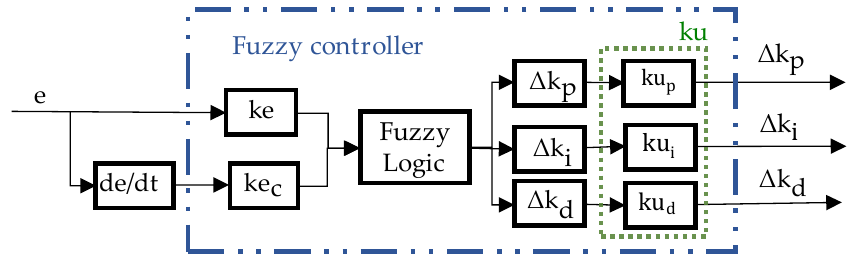
Figure 7. The structure diagram of the fuzzy PID controller.